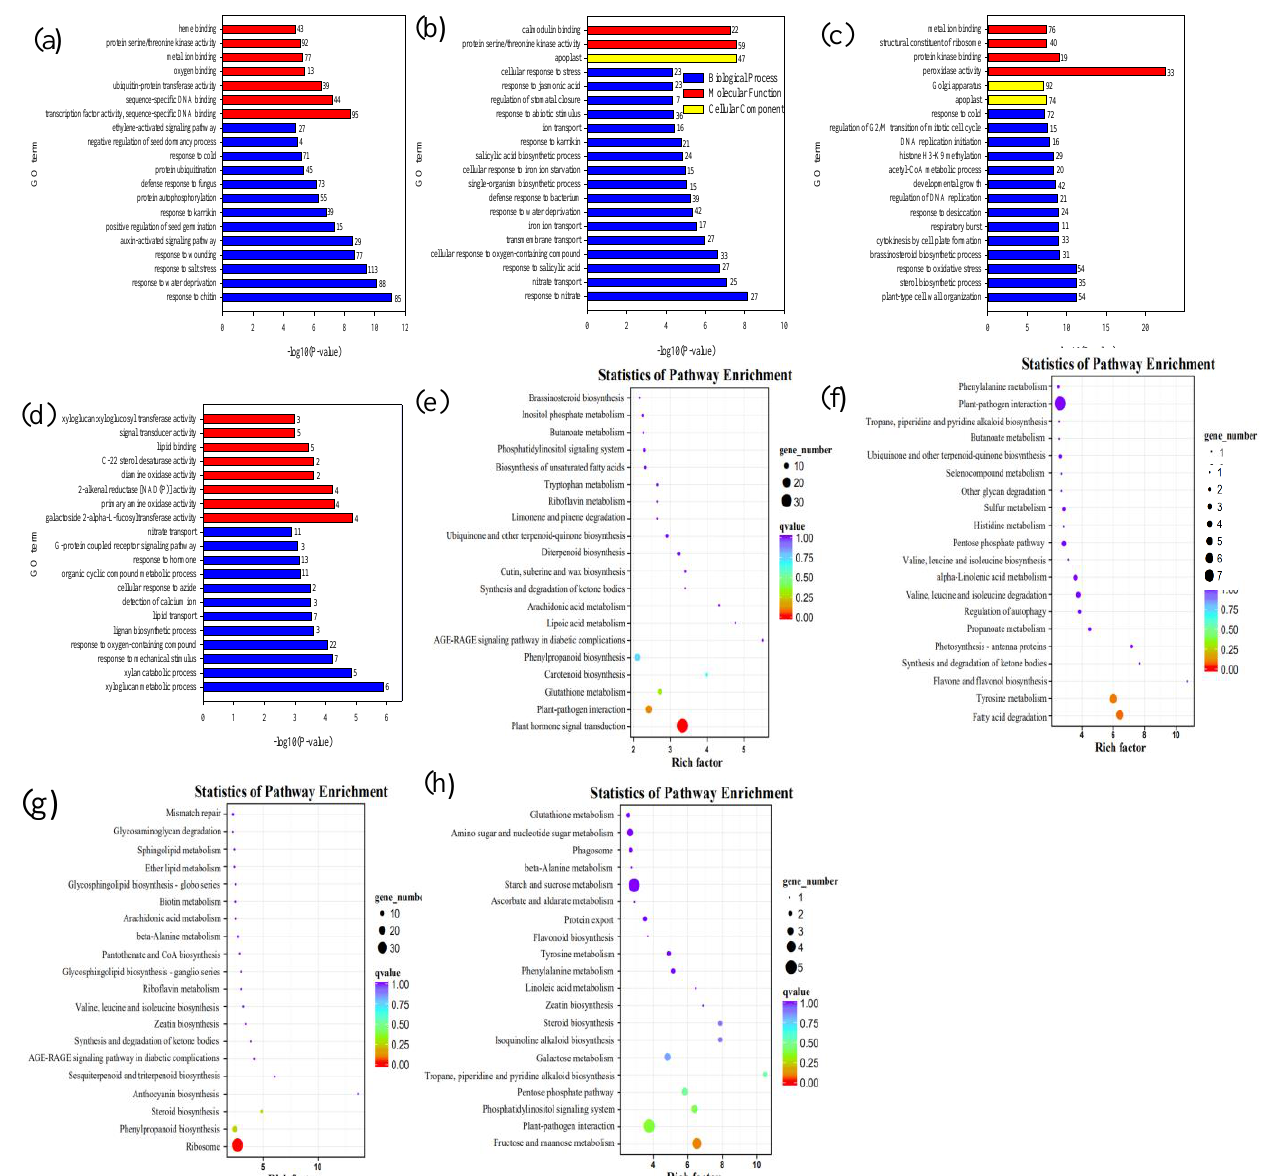
Figure 6. Functional analysis of differential expressed genes induced by Al in two indica rice cultivars. Gene Ontology (GO) enrichment analysis ( a – d ); Kyoto Encyclopedia of Genes and Genomes (KEGG) pathway enrichment analysis ( e – h ) of uniquely upregulated genes ( a , b , e , f ) and downregulated ( c , d , g , h ) genes in Kasalath ( a , c , e , g ) and Jinguoyin ( b , d , f , h ). The 20 most enriched GO terms with the lowest p -values are listed .